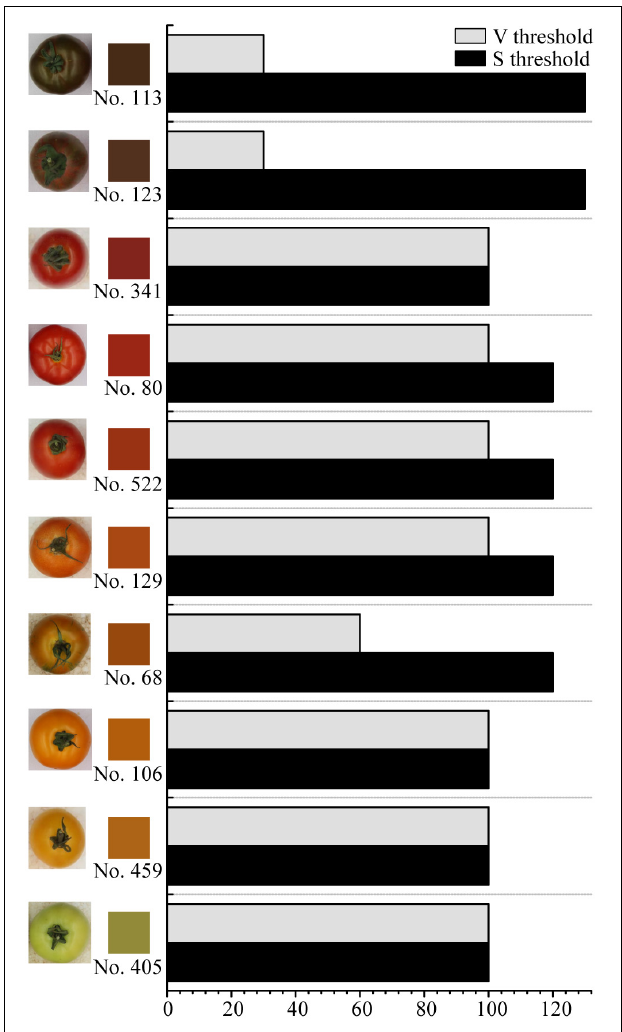
FIGURE 2 | Fruit average colors and thresholds for Hue-Saturation-Value (HSV) filtering and binarization of the intact fruit images. The square beside each tomato fruit image shows the fruit average color in RGB mode. Fruit images are not